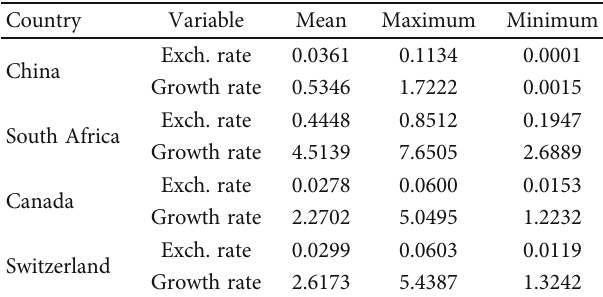
Table 6: Descriptive statistics for moving